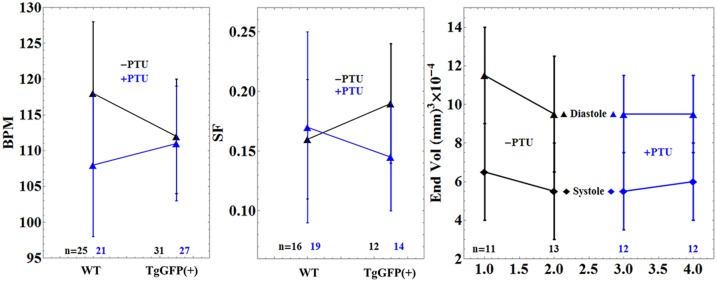
Comparison of heart rate in Beats Per Minute (BPM), Shortening Fraction (SF), and cyclical ventricle volume changes for WT and TgGFP(+) embryos in the presence (blue) and absence (black) of PTU treatment.Error bars show standard deviation for n embryos.